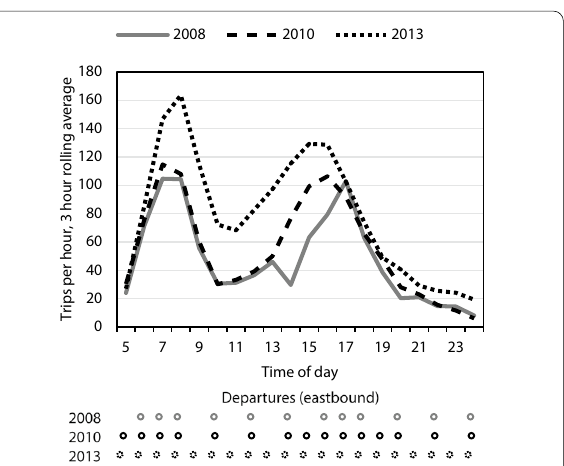
Fig. 5 Centred three‑hour rolling average of trips per hour on Österlenbanan (case B) on a typical weekday in 2008, 2010, and 2013. The circles below the chart represent departure